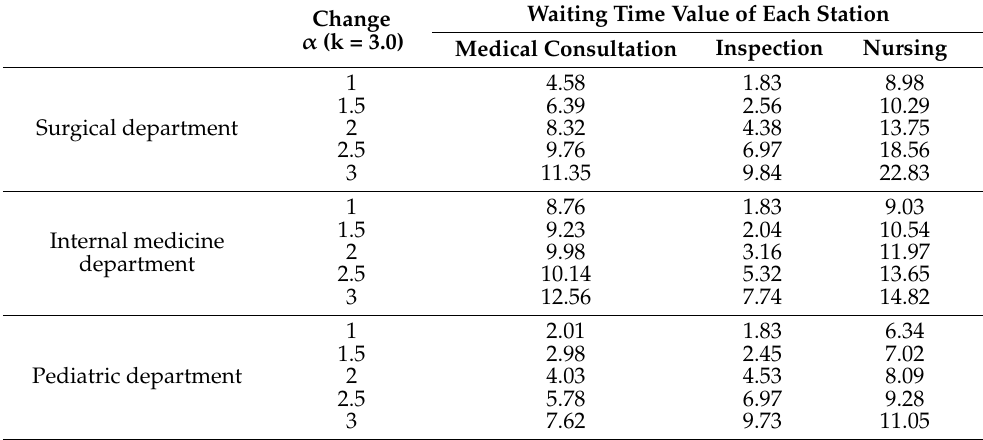
Table 4. Results of burst entry simulated using Pareto distribution.